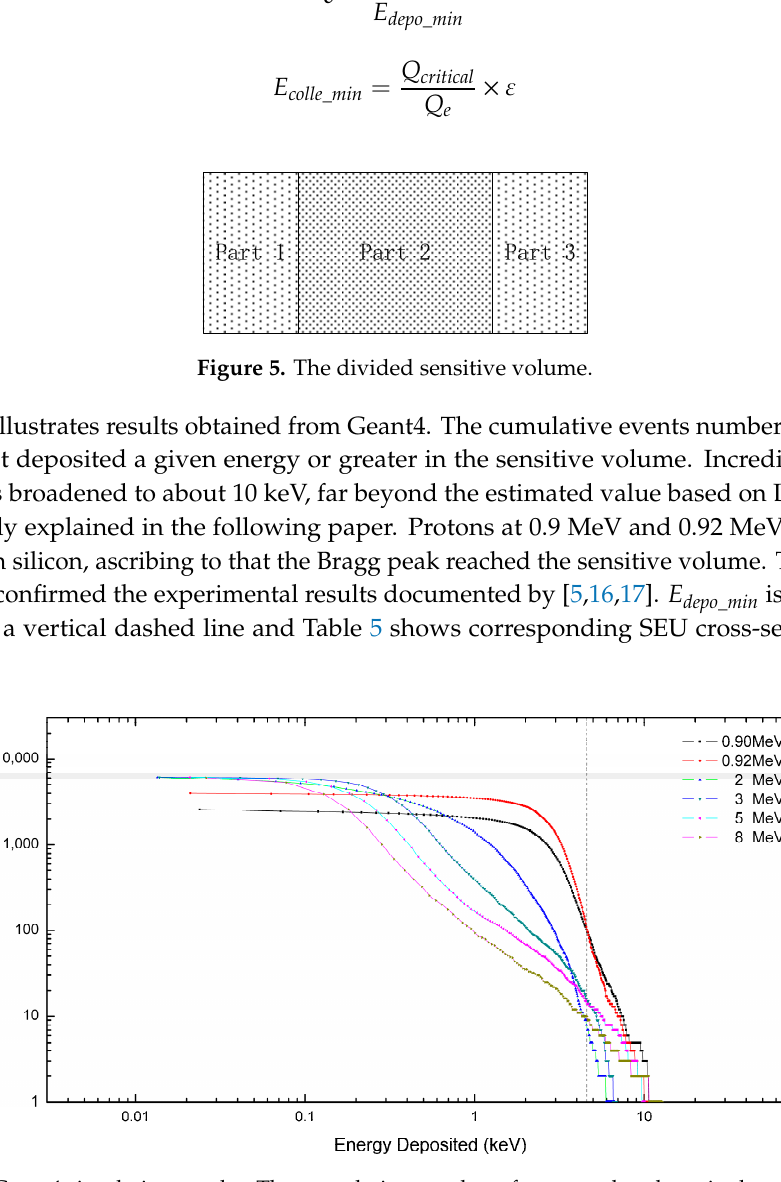
Figure 6. Geant4 simulation results. The cumulative number of protons that deposited a given energy or greater in the sensitive volume for various initial energy of the proton beam. Table 5. Simulation results of single event upset (SEU) cross-sections.